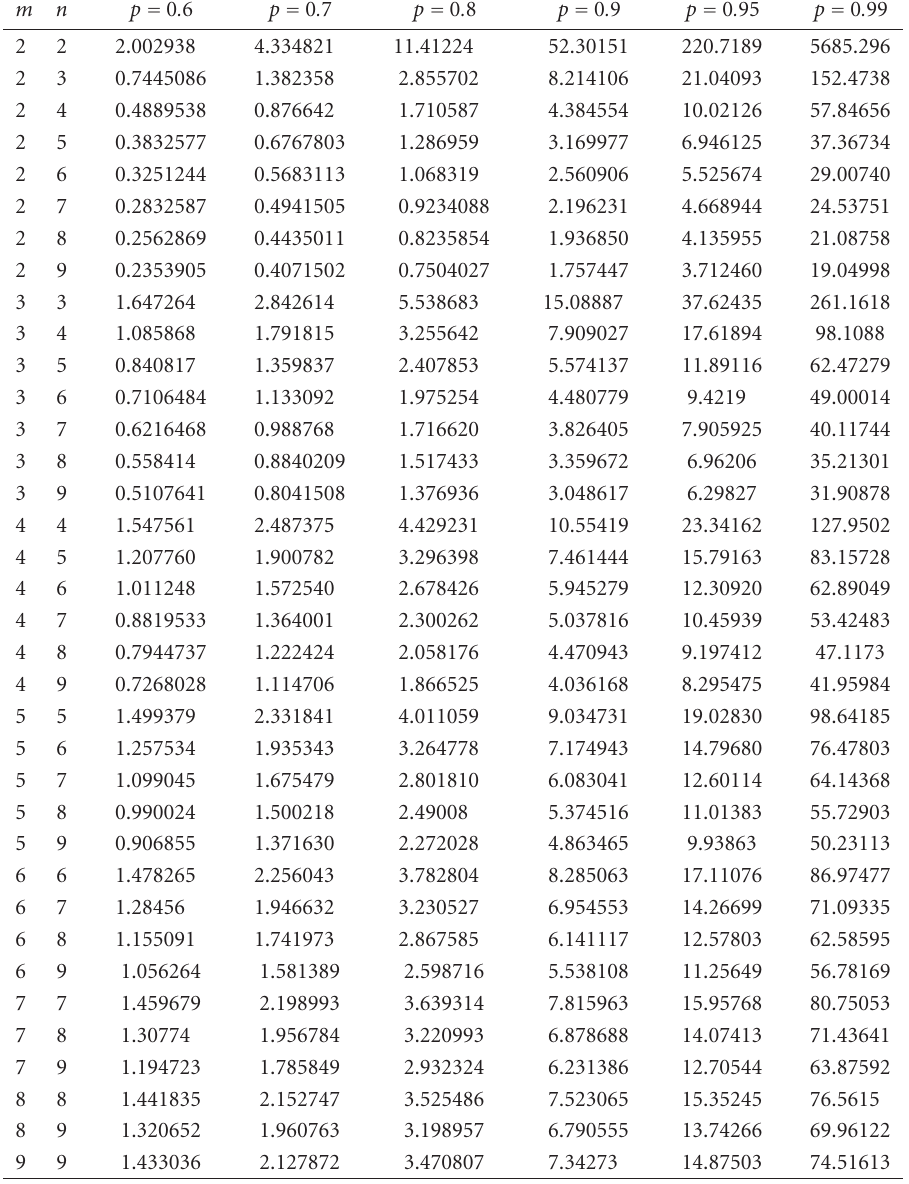
Table 4.2. Percentage points z p of Z = | X/Y |